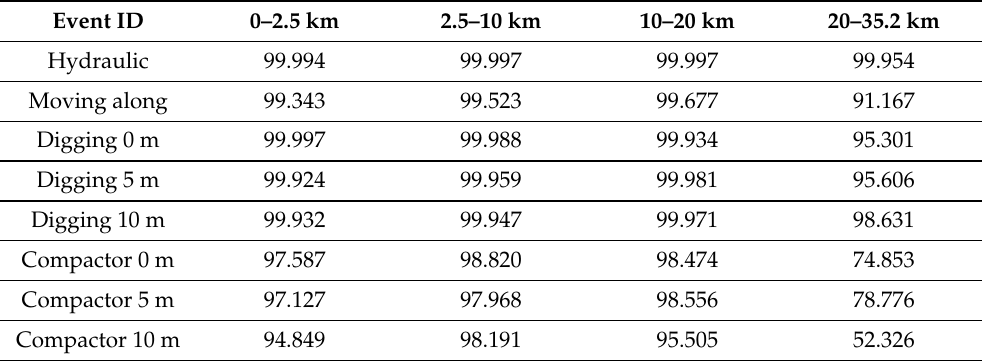
Table 2. AUC (%) for different events and distances.